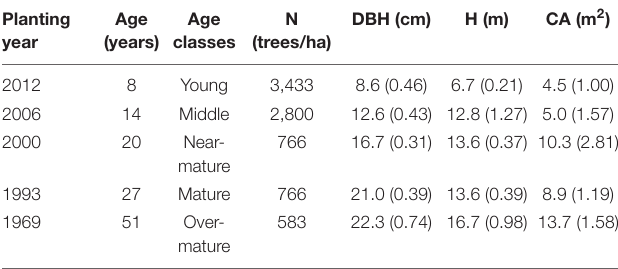
The values in brackets are standard deviation values. N, represents the stand density. DBH, represents the average diameter at breast height of five sampled trees in each stand. H, represents the average height of five sampled trees in each stand. CA, represents the average area of tree crown of five sampled trees in each stand.